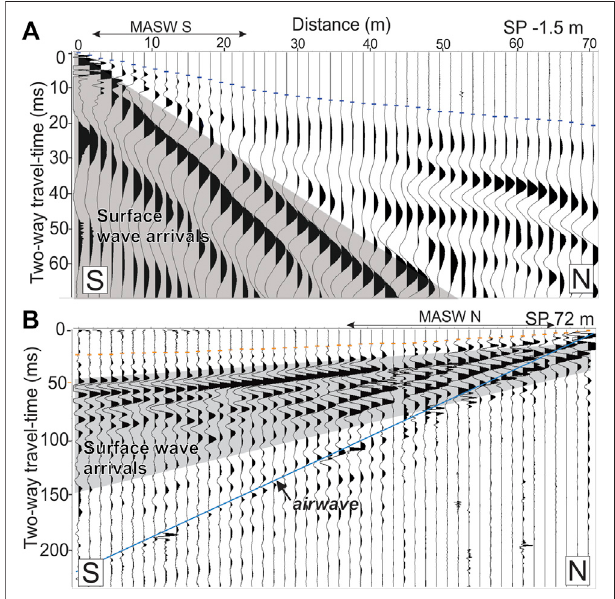
FIGURE 2 | (A) First 70 ms of stacked seismic shot gather acquired at the Lateral Moraine Site, with the shot location S − 1.5. First-break picks are marked with blue dashes. (B) First 230 ms of reverse seismic shot gather at theLateralMoraineSitewithshotlocationS72.Sectionsaredisplayedin positive standard polarity. First-break picks are marked with orange dashes. Grey areas highlight surface wave arrivals and geophone offsets used in MASW analysis are de fi ned with “ MASW S ” and “ MASW N ” for the southern and northern ends of the line,